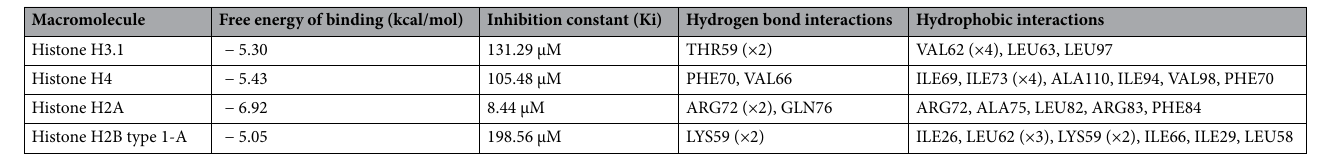
Table 3. Potential molecular interactions and binding affinities of AFM 1 with histone